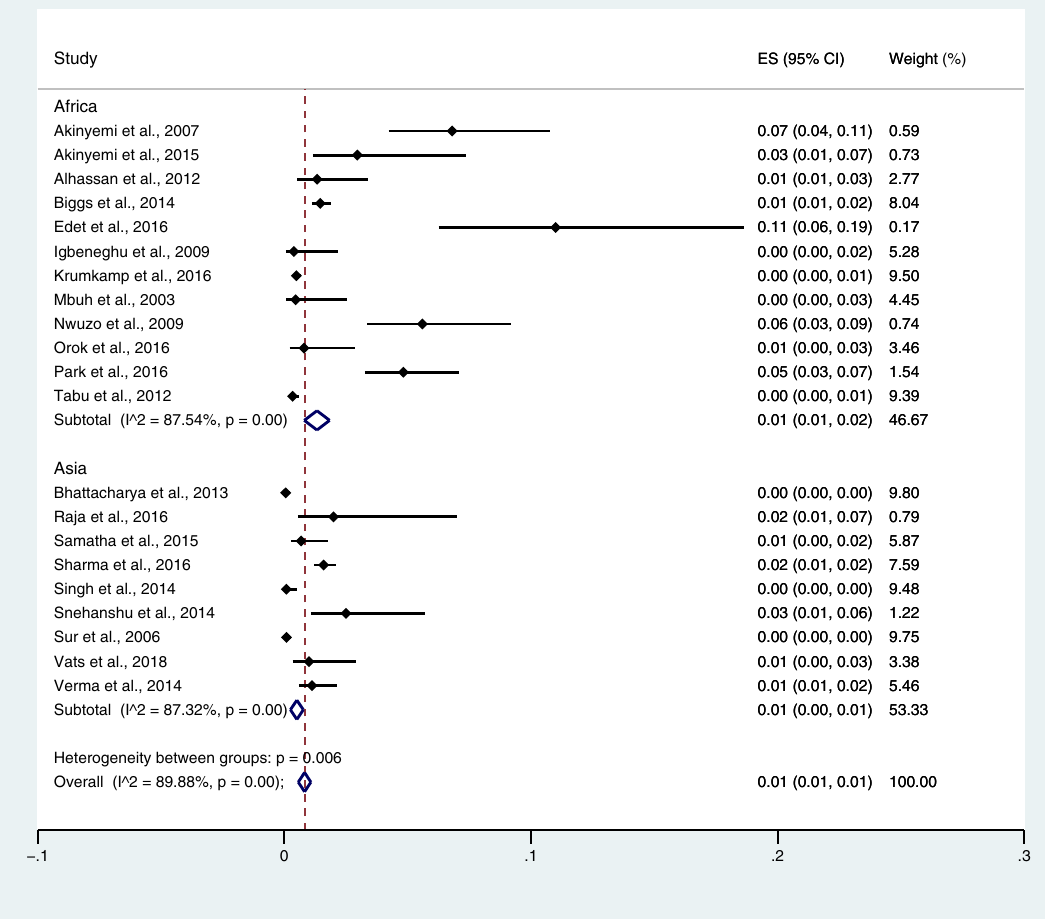
Heterogeneity between groups: p = 0.006 Overall (I^2 = 89.88%, p =